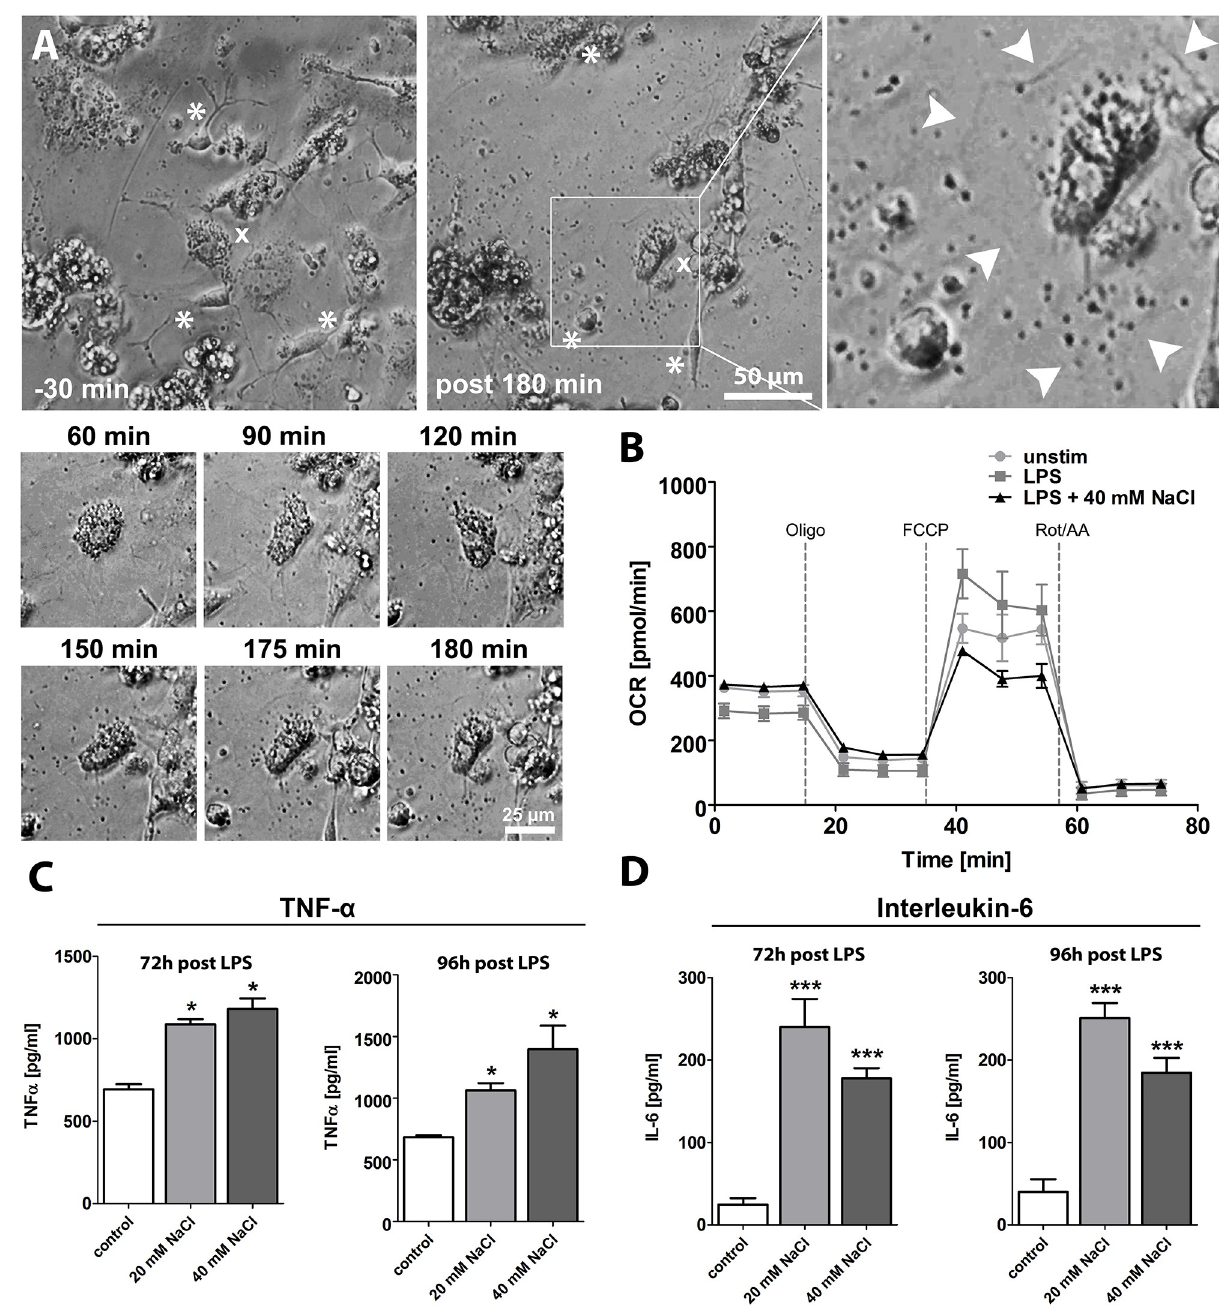
Fig 5. Sodium chloride induces microglial migrasome formation and promotes a pro-inflammatory polarization of microglia, whereas the cells’ metabolism remains unaltered. (A) After application of 20 mM NaCl to a primary murine microglia and astrocyte co-culture, we firstly observed the appearance of vesicle-like structures and subsequently, we observed morphological changes of microglia and astrocytes. Note that images have been enhanced regarding contrast to make structural differences better visible. (B) Sodium chloride delivery did not influence the mitochondrial respiration of microglia (p = 0.31, 2way ANOVA). (C) Incubation of a murine microglia cell culture with lipopolysaccharide (LPS) plus either solvent or sodium chloride (20 mM and 40 mM) for 72 h to 96 h resulted in a significantly increased concentration of pro-inflammatory cytokine TNF- α in the supernatant (p < 0.05, 1way ANOVA). (D) Incubation of a murine microglia cell culture with lipopolysaccharide (LPS) plus either solvent or sodium chloride (20 mM and 40 mM) for 72 h to 96 h resulted in a significantly increased concentration of pro-inflammatory cytokine IL-6 in the supernatant (p < 0.001, 1way